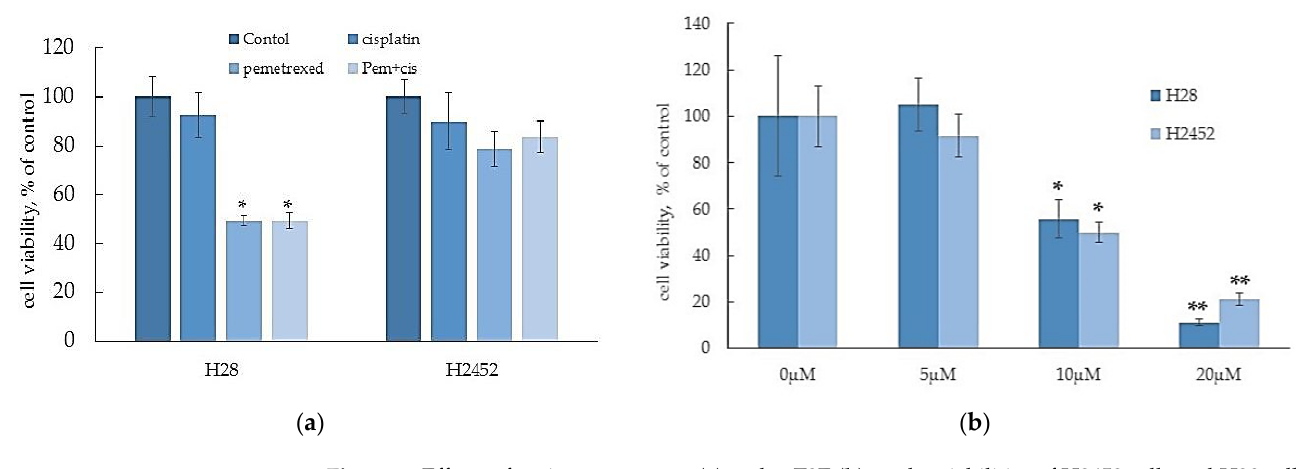
Figure 1. Effects of anti-cancer agents ( a ) and α -T3E ( b ) on the viabilities of H2452 cells and H28 cells. Cells were treated with cisplatin (5 µ M), pemetrexed (2.5 µ M), a combination of cisplatin (5 µ M) and pemetrexed (2.5 µ M), and α -T3E (0 – 20 µ M) for 24 h, and each cell viability was evaluated by the WST-8 assay as described in Section 4.4. The data are means ± SD, n = 5. * p < 0.05, ** p < 0.01 vs. the control.